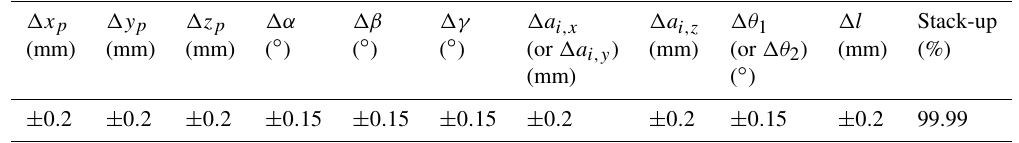
Table 4. Experience based tolerance assignment for the L/R mechanism.